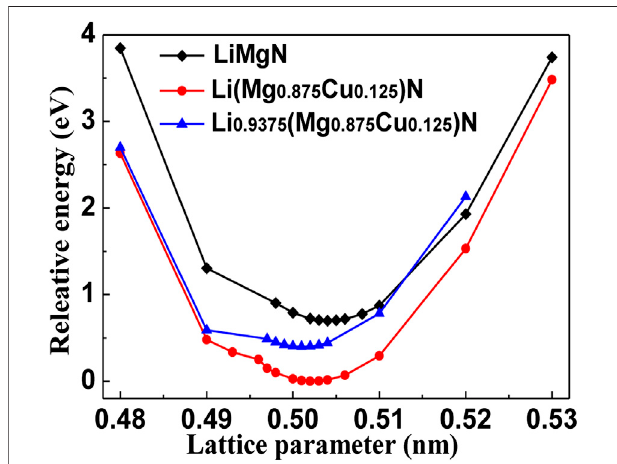
FIGURE 2 | The relative energy as a function of lattice constants for Li 1- y (Mg 1- x Cu x )N.